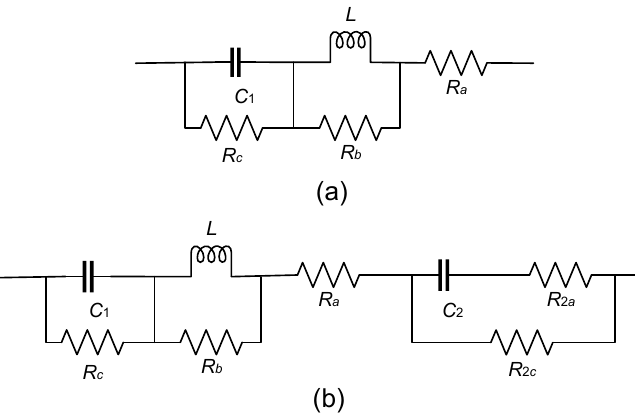
Figure 5. Electrical model of electrolytic capacitors with parameter identification done by applying genetic algorithm on the frequency data. Note that ( b ) is an extended version of ( a ) with the extended circuit parameters allowing room to factor in the effects of temperature.